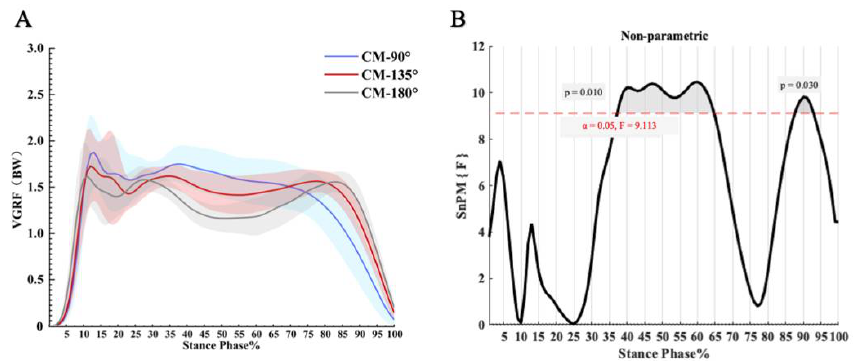
Figure 3. ( A ) Three CM directions of the vertical ground reaction force; ( B ) The SnPM statistics comparison.